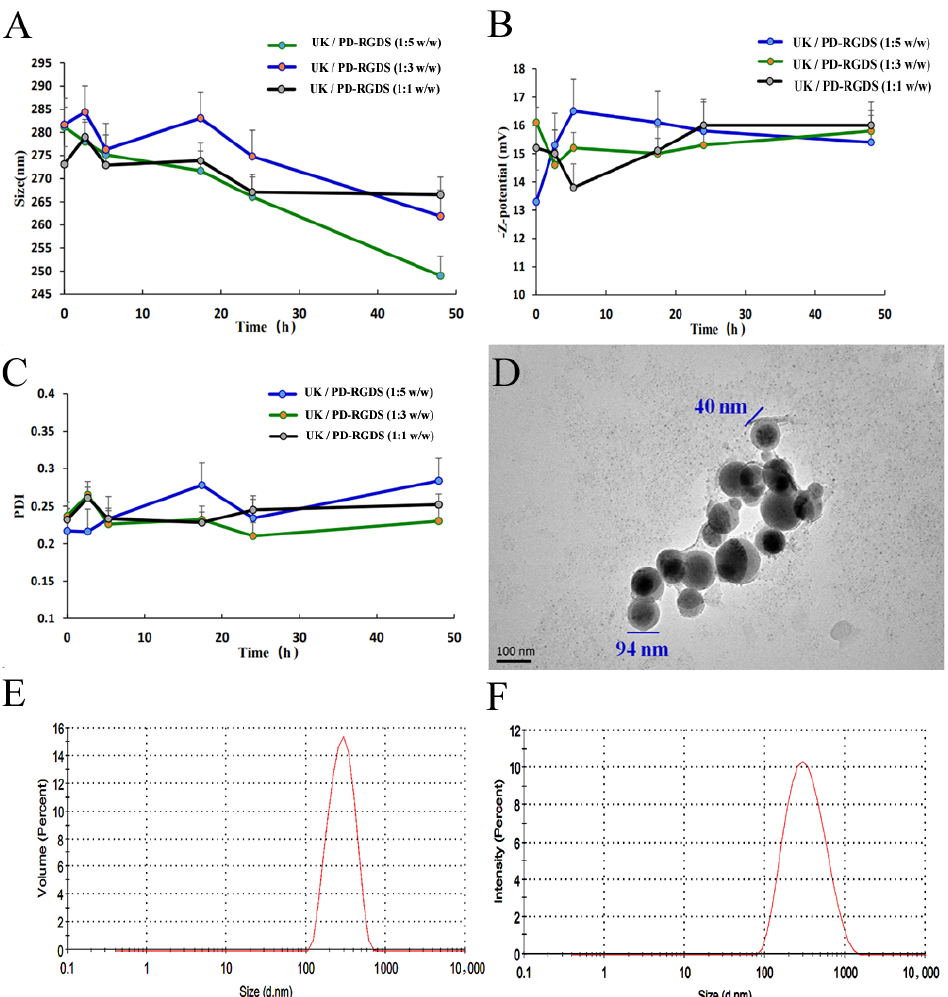
Figure 1. Physical characterization of the UK/PD-RGDS complex. ( A ) Effect of complexation ratio on z-average sizes of UK/PD-RGDS complexes in consecutive 48 h. ( B ) Effect of complexation ratio on Zeta potentials of UK/PD-RGDS complexes in consecutive 48 h. ( C ) Effect of complexation ratio on the size distribution of UK/PD-RGDS complexes in consecutive 48 h. ( D ) TEM image of the UK/PD-RGDS complex (1:1 w / w ). ( E ) The size distribution of the UK/PD-RGDS complex (1:1) was measured by dynamic light scattering method. ( F ) The size distribution of the PD-RGDS measured by dynamic light scattering method.